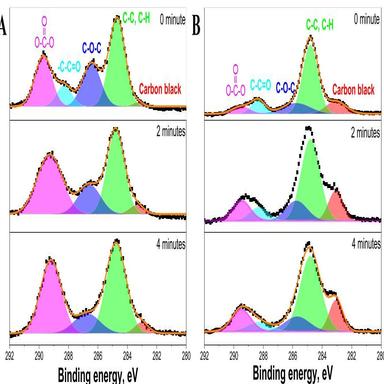
Depth profile of C1s XPS spectra of discharged (0.02 V) microsized Sn electrode in (A) ether-based and (B) carbonate-based electrolytes.